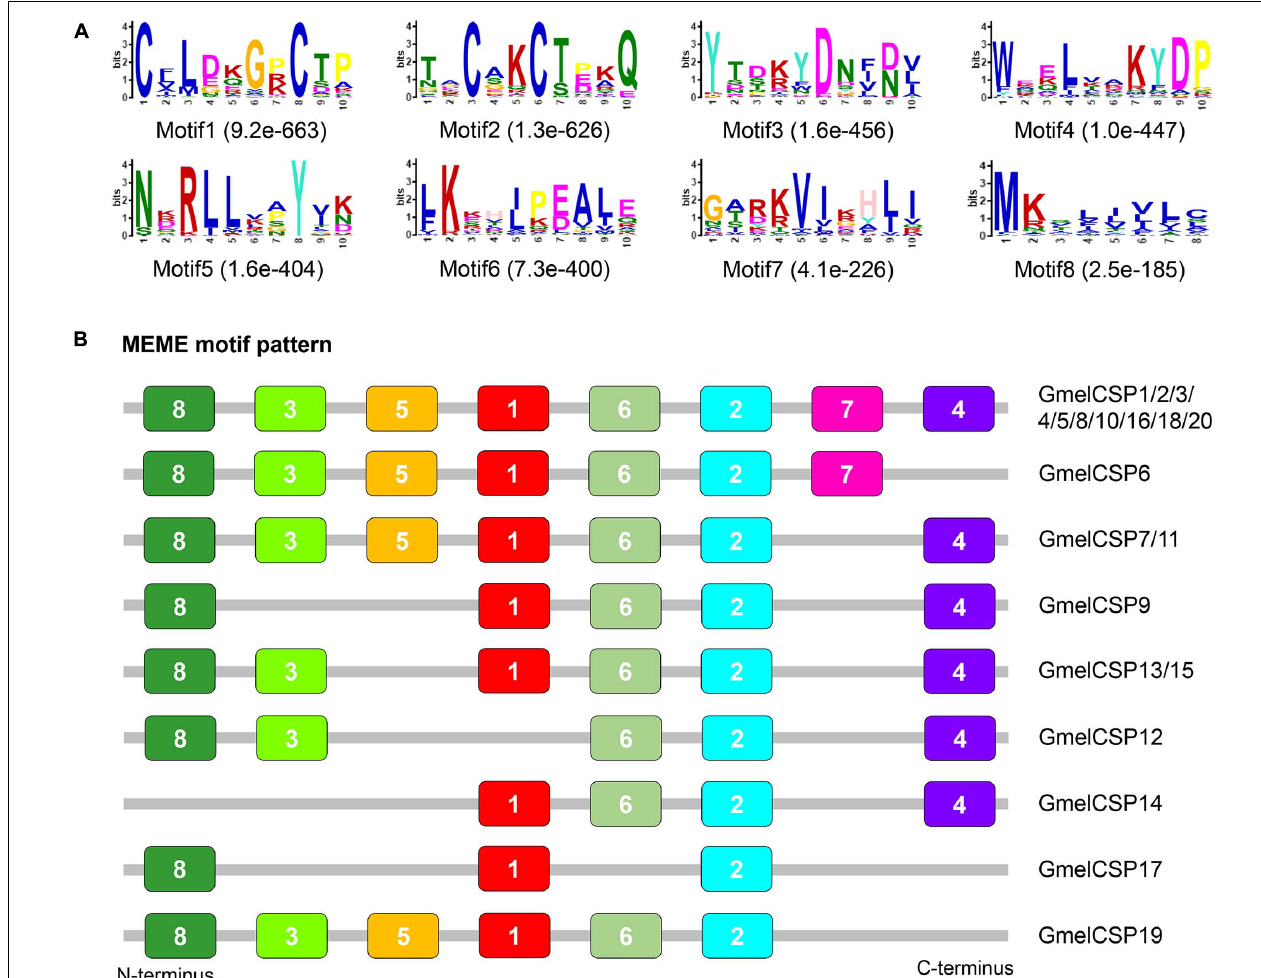
FIGURE 5 | Motif pattern analysis of G. mellonella CSPs. (A) Eight motifs (motif 1–8) discovered in GmelCSP proteins and their lepidopteran homologs. The number in the parentheses indicated the expect-value ( e -value) calculated by MEME program. (B) Locations of each motif in the protein sequences. The numbers in the colored boxes correspond to the numbered motifs in (A) . The CSP protein sequences used are listed in Supplementary Table 2